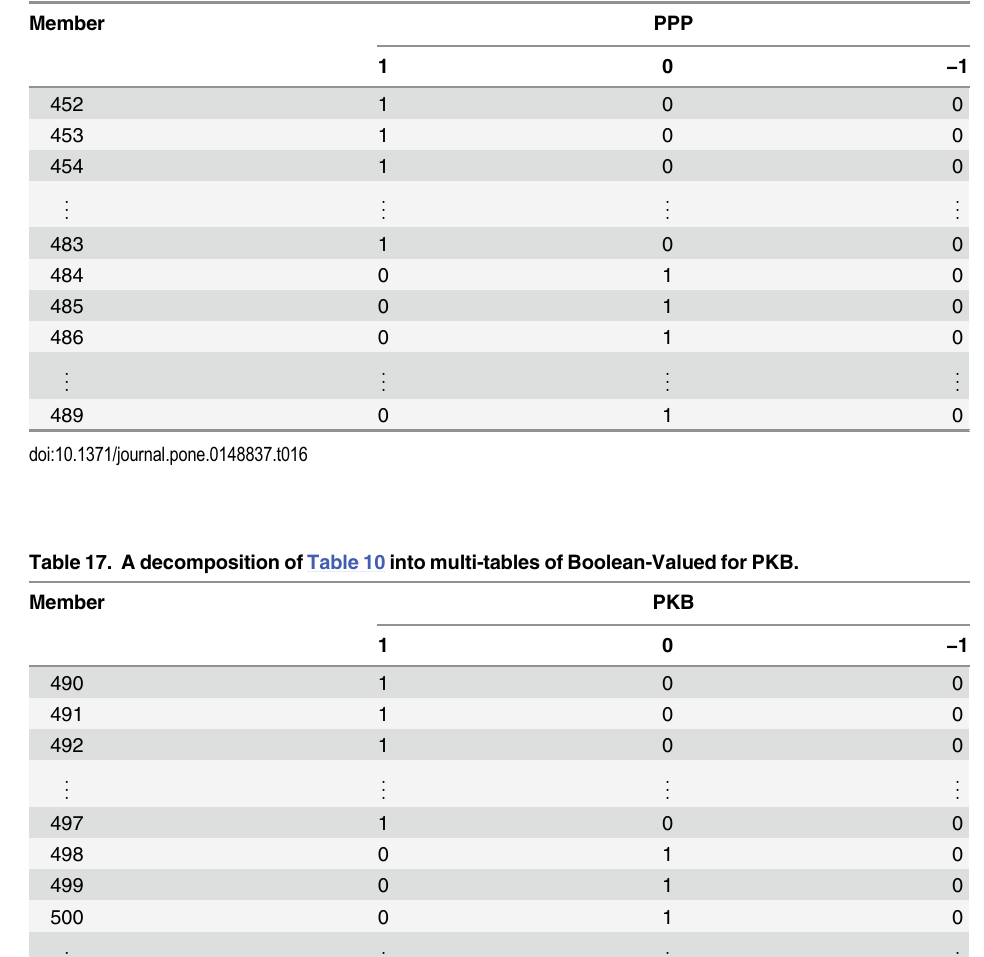
Table 15. A decomposition of Table 10 into multi-tables of Boolean-Valued for PAN. Member PAN 1 0 − 1 406 1 0 0 407 1 0 0 408 1 0 0 . .. . .. . .. . .. 449 1 0 0 450 0 0 1 451 0 0 1